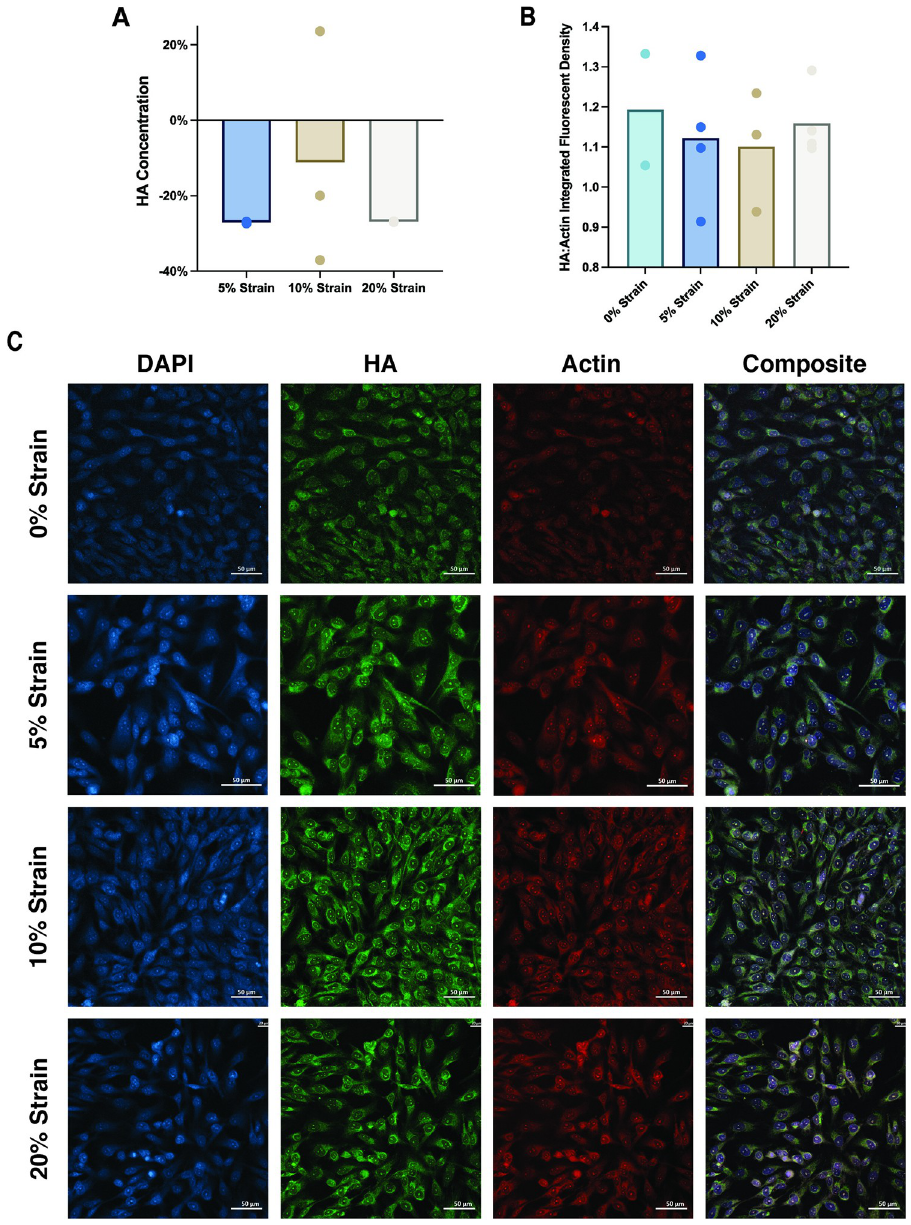
Fig 4. Hyaluronan content is sensitive to changes to cyclic strain. A) Overall hyaluronan concentration (ng/mL). B) Integrated density of hyaluronan staining (green, Alexa Fluor-488) normalized to fluorescent intensity of actin staining (red, Phalloidin-565). C) Representative immunofluorescent images of DAPI, hyaluronan, and F-actin stains and a composite image of all strain groups. Dots represent individual samples and significant differences between groups are shown with brackets. Scale bar = 50 μ